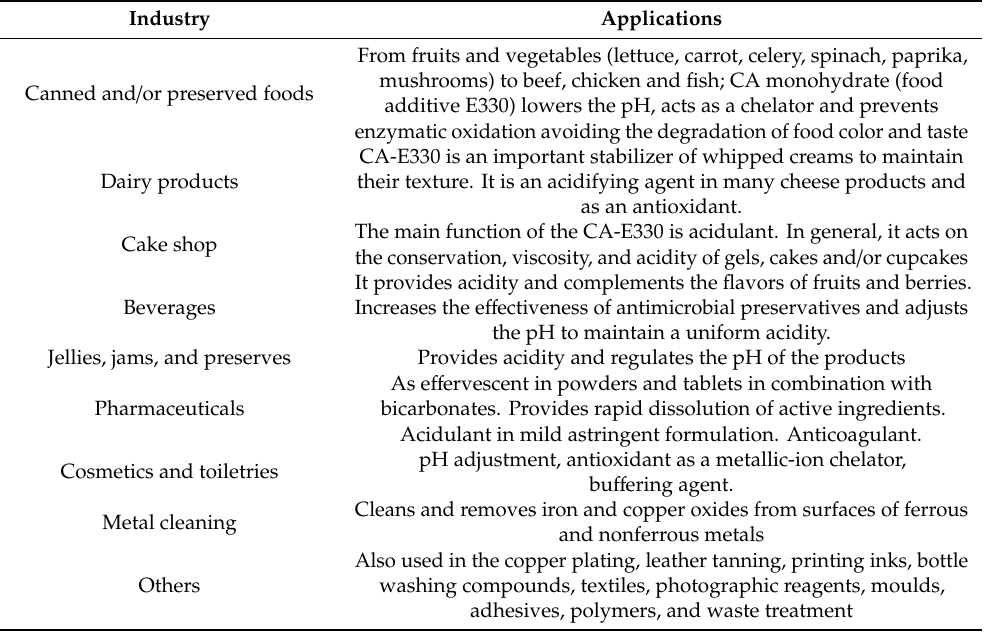
Table 3. Main applications of citric